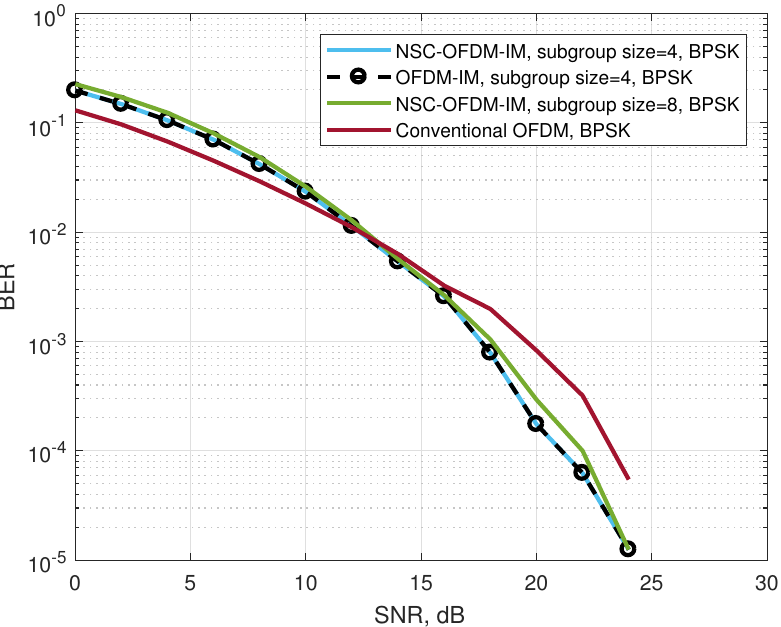
Figure 8. BER performance comparison between the proposed NSC-OFDM-IM and conventional OFDM-IM/OFDM, where the BPSK modulation was